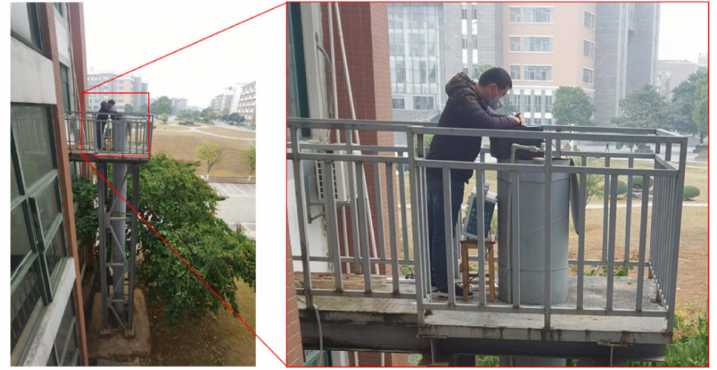
Figure 24. The experiments under the artificial water well.